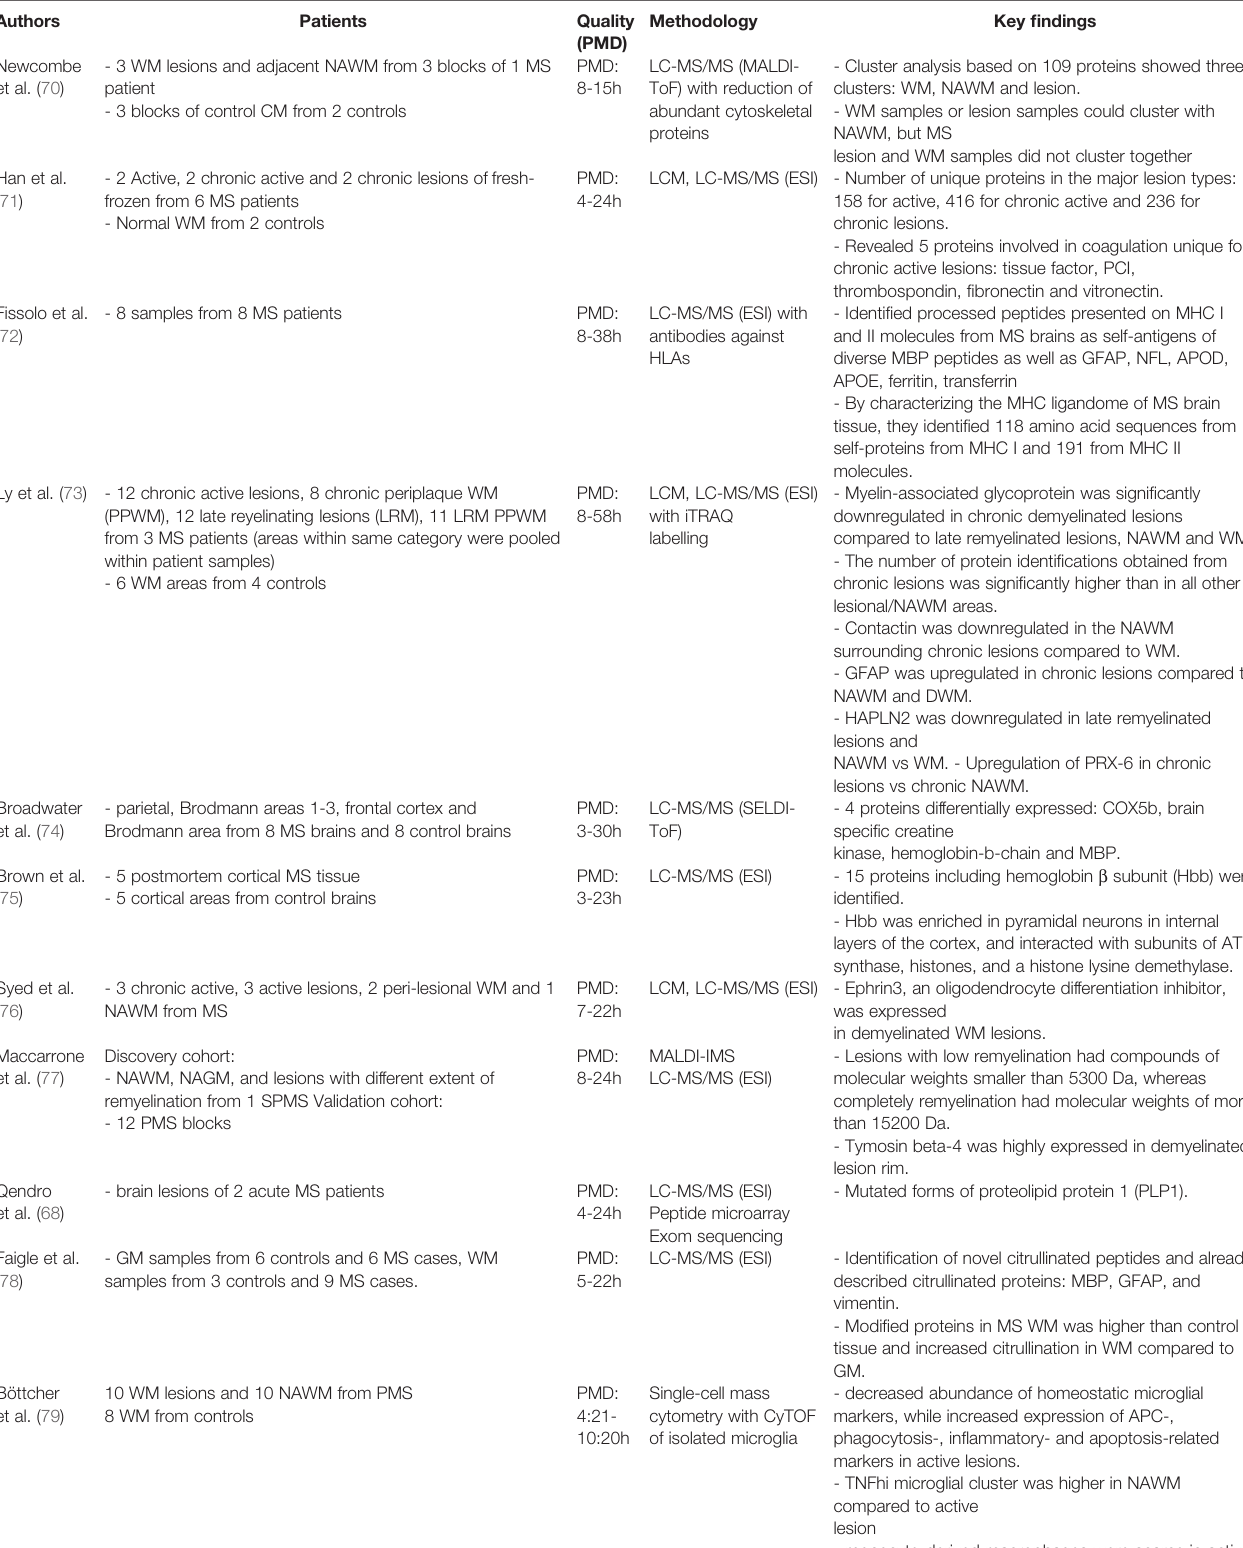
TABLE 3 | An overview of the studies (n=11) that examined the proteome pro fi le in human MS brain